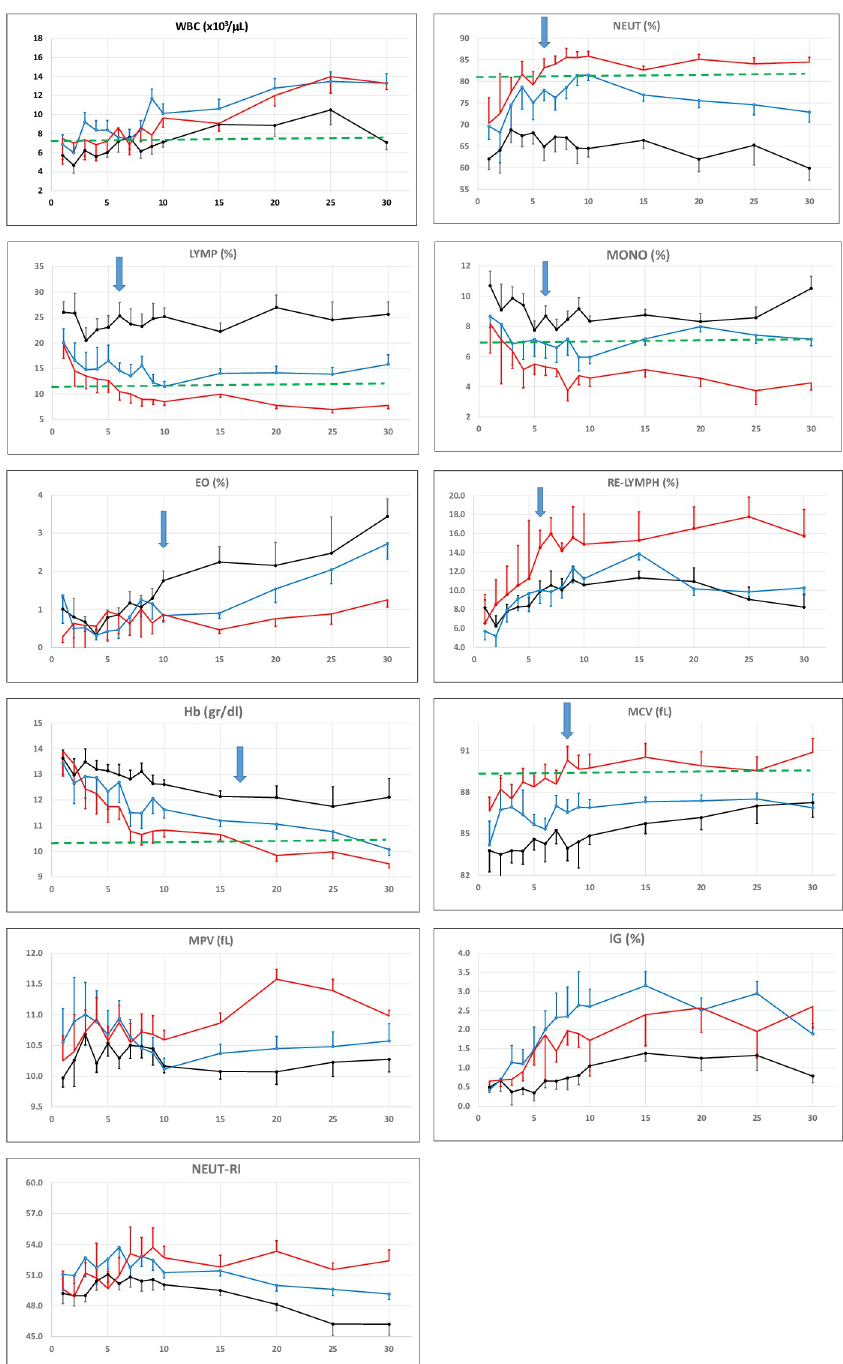
Fig 6. Trend graphics of time-related CBC-Diff parameters. Abbreviations: Black line: Non-critical survivors, Blue line: Critical-survivors, Red line: Non-survivors. Trends of CBC parameters over 30 days of hospitalisation in mild/ moderate, severe, non-survivor patients. 30 days of hospitalisation refers to Day 0 and the next days after admission. The dotted horizontal line: Limit of reference value. WBC ( x 10 3 ): of White Blood Cells, NEUT (%): % of Neutrophils, LYMPH (%): % of Lymphocytes, MONO (%): % of Monocytes, EO (%): % of Eosinophils, RE-LYMPH (%): % of Reactive lymphocyte, Hct (%): Haematocrit, Hgb: Haemoglobin (g/dl), MCV: Mean Cell Volume (fL), IG (%): % of immature granulocytes, MPV: Mean Platelet Volume (fL), NEUT-RI: Neutrophil Reactivity Index.